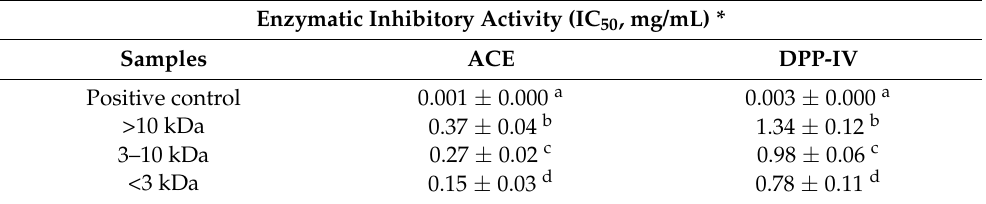
Table 1. Inhibitory activity (expressed as IC 50 or oligopeptide concentration needed to inhibit the original enzyme activity by 50%) of oligopeptide fractions by ultrafiltration against angiotensin- converting enzyme (ACE) and dipeptidyl peptidase-IV